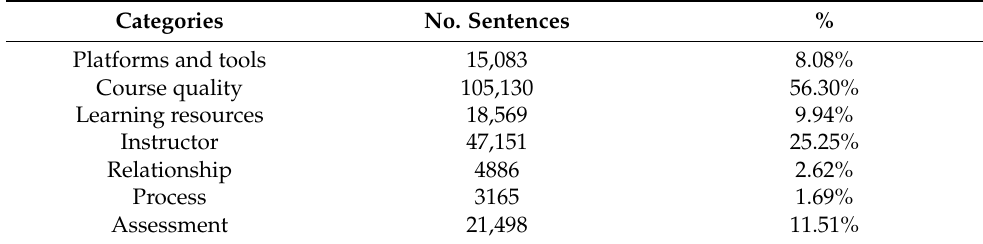
Table 4. Distribution of different